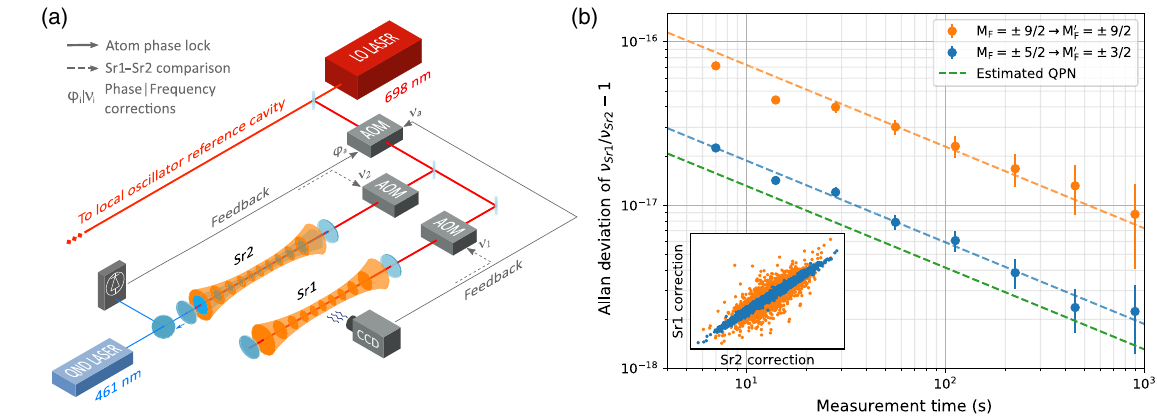
FIG. 3. Experimental setup and Sr1-Sr2 correlations. (a) LO light is distributed to Sr1 and Sr2 along separate optical paths, the lengths of which are actively stabilized. When the APL is engaged, phase corrections from Sr2 are applied to an acousto-optic modulator (AOM) shared by both systems, thereby increasing the coherence time of the light sent to Sr1. (b) Allan deviation of the frequency ratio between Sr1 and Sr2, with the APL disengaged and the OLCs independently stabilized using synchronous 300 ms Rabi pulses. Both clocks experience the same LO frequency fluctuations, resulting in highly correlated frequency corrections ν 1 , ν 2 . However, there are residual sources of noise — for example, linear Zeeman shift fluctuations, which are suppressed using a less sensitive Zeeman transition. After minimizing noise (see Supplemental Material [39]), the frequency instability approaches the quadrature sum of QPN from both clocks, ffiffiffi p 4 × 10 − 17 = τ . The cycle time is 1.75 s and atom numbers are 7 × 10 3 and 1 . 3 × 10 4 atoms in Sr1 and Sr2, respectively.